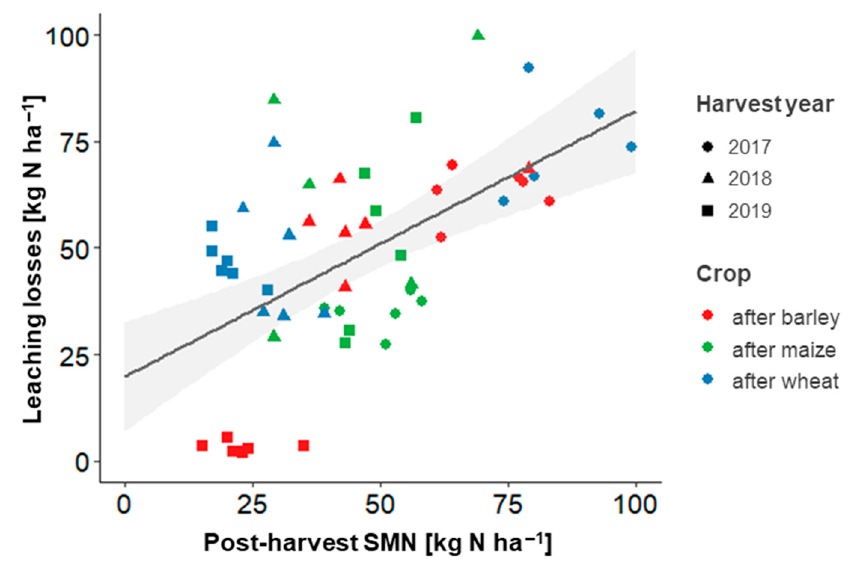
Figure 6. Relation between post-harvest soil mineral nitrogen (SMN) and nitrogen leaching losses below the root zone.